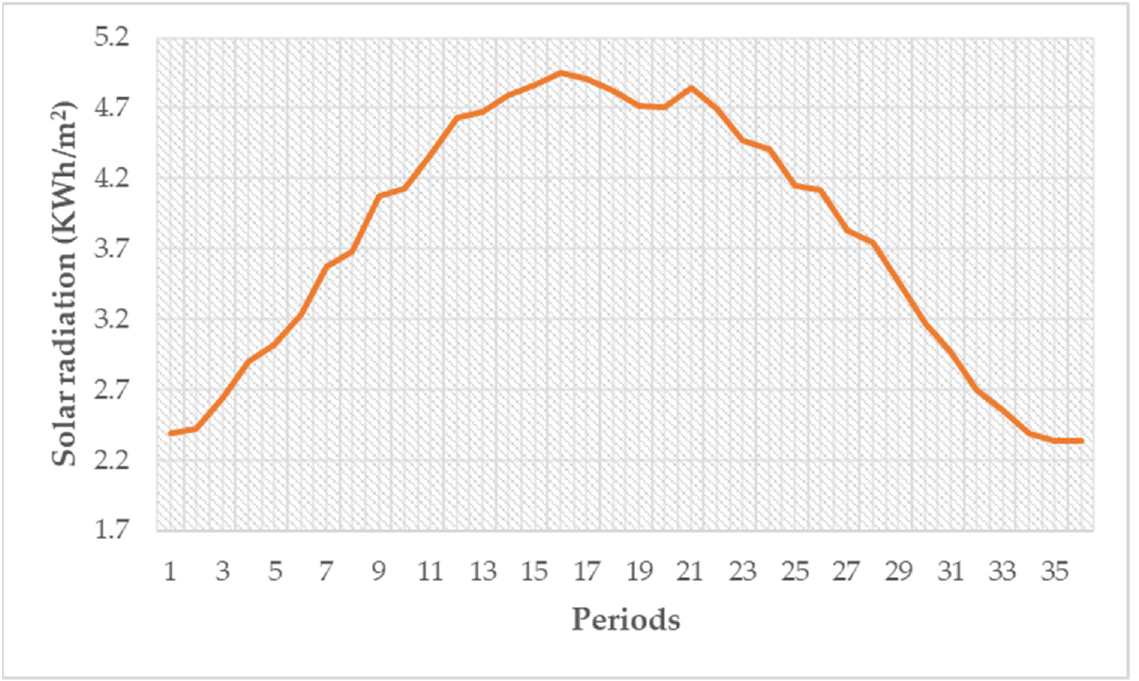
Figure 13. Change in 10-day average daily total PV energy in China for 36 periods .